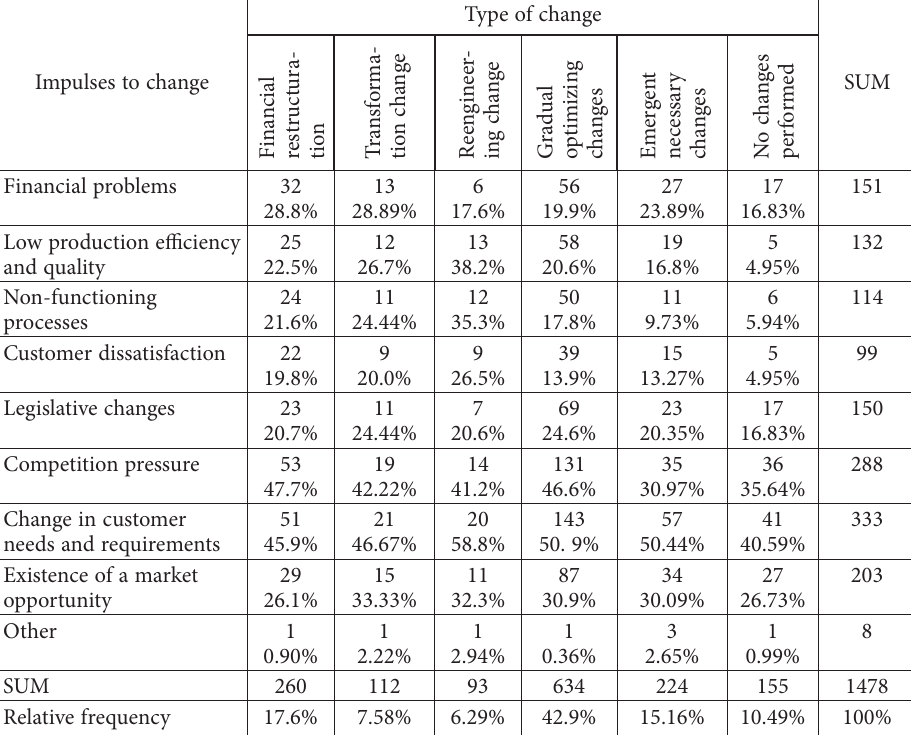
Table 2. Pivot table for type of change and impulses to change (source: own processing)